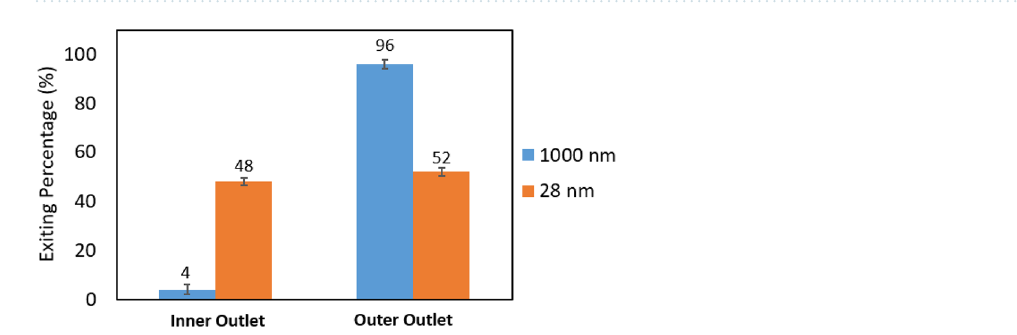
Figure 9. Results of an inertial focusing test on a mixture of 28 nm and 1000 nm polystyrene particles (test B3). Exiting percentage of particles from the inner outlet (left) and the outer outlet (right). n = 3, error bars = standard deviation (SD).